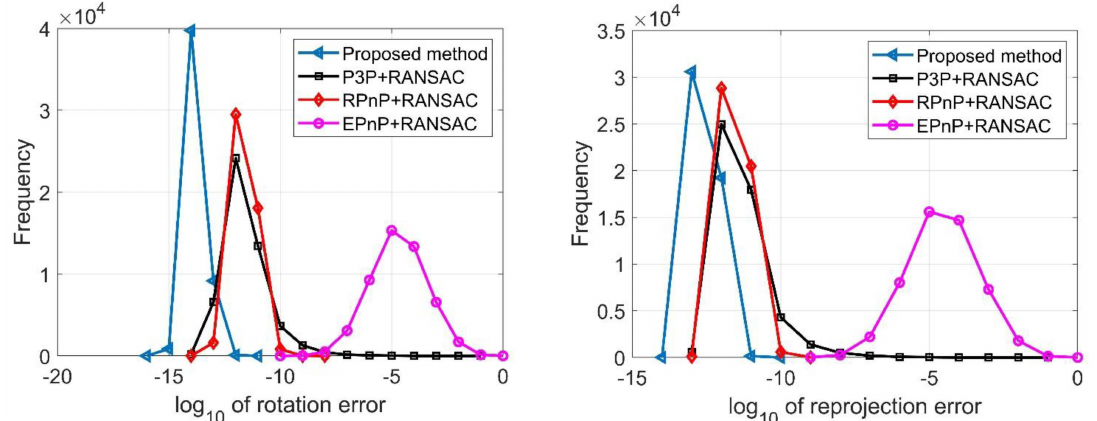
Figure 7. Numerical stability of rotation ( left ) and reprojection ( right ) for our proposed method (blue), P3P + RANSAC (black), RPnP + RANSAC (red), and EPnP + RANSAC (purple).